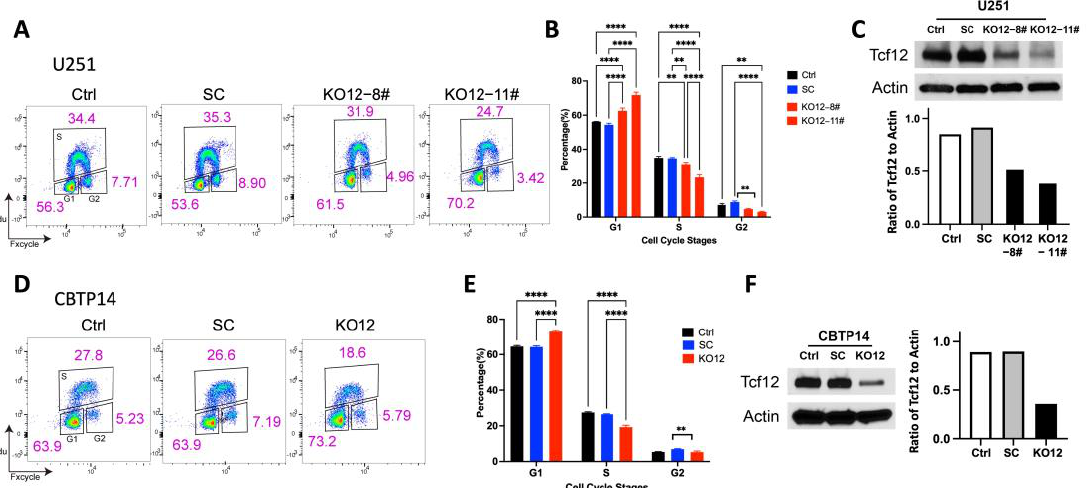
Figure 3. Tcf12 regulates proliferation in the human GBM cell line U251 and patient−derived GSC cells. ( A ) Graphical representation of the flow cytometry for EdU proliferation assays on two TCF12 knockout U251 clones, KO12−8# and KO12−11#, with controls. Cell cycle phases are indicated with the relative cell numbers in each phase. ( B ) Quantitative result from ( A ), n = 3 per cell type. ( C ) Western blot showing complete knockout of TCF12 in U251 cells. ( D ) Graphical representation of the flow cytometry of EdU proliferation assays on TCF12 knockout GSC clones of CBTP#14, with controls. ( E ) Quantitative result from ( D ), n = 3 per cell type. ( F ) Western blot showing complete knockout of TCF12 in patient-derived GSC CBTP#14 cells. The uncropped blots are shown in Figure S3. ** p < 0.01, **** p < 0.0001 ( B , E